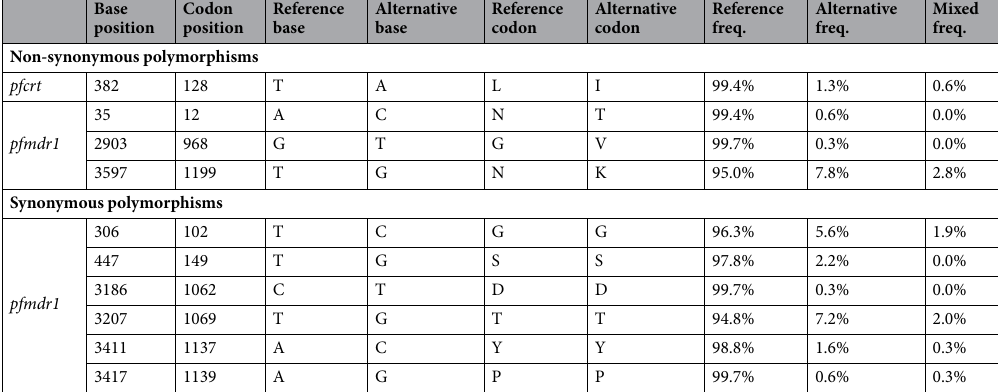
Table 3. Other polymorphisms in pfcrt and pfmdr1 . The table describes polymorphisms identified amongst the 318 resistance-profiled samples in pfcrt and pfmdr1 other than the positions of interest indicated on Fig. 3 and Table 2. The frequencies of both the reference and alternative are listed, as well as the frequency of mixed infections. Note that mixed infections were counted in both the reference and alternative